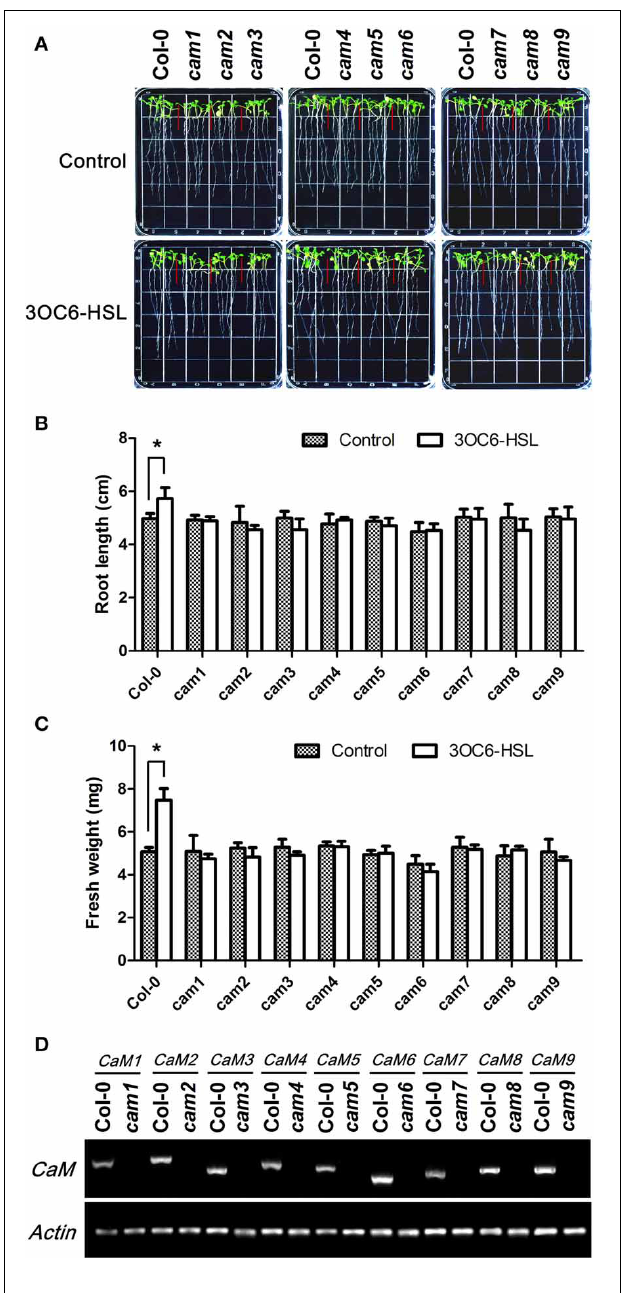
FIGURE 6 | The stimulating effect of 3OC6-HSL on primary root elongation is diminished in loss-of-function mutants of individual AtCaM genes. (A) Images of Arabidopsis wild-type plants and CaM functional-deficiency mutants cam1, cam2, cam3, cam4, cam5, cam6, cam7, cam8, and cam9 grown side by side on vertically oriented plates containing with or without 1 μ M 3OC6-HSL after 7 days of cultivation. (B) Plot of effect of 3OC6-HSL on primary root length in wild-type seedlings and cam1-cam9 mutant seedlings. (C) Plot of effect of 3OC6-HSL on fresh weight in wild-type seedlings and cam1-cam9 mutant seedlings. Each experiment included at least 30 seedlings for each genotype and treatment. Data shown are the average of four independent experiments. Entries with p -values < 0.05 shown with asterisk. (D) Identification of CaM null mutants by RT-PCR. Total RNA was extracted from the leaves of one-month-old